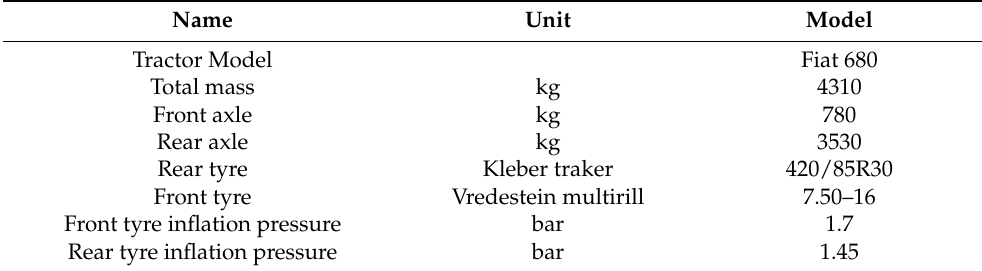
Table 1. Technical data of the tractors used in the